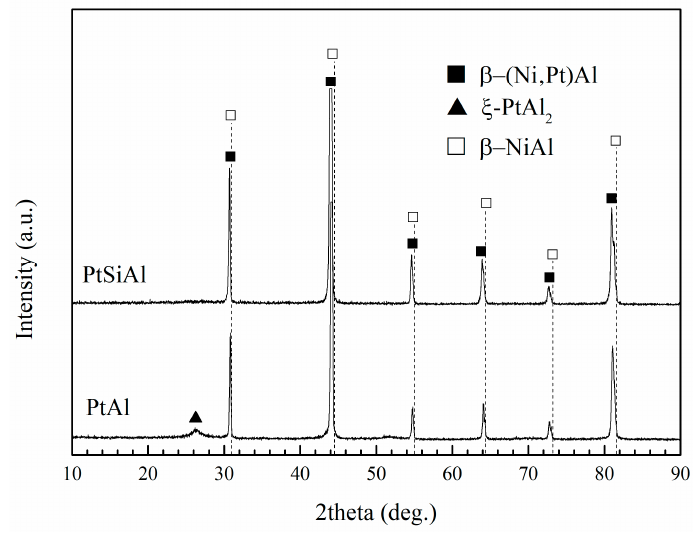
Figure 1. XRD patterns of the PtAl and PtSiAl coatings.